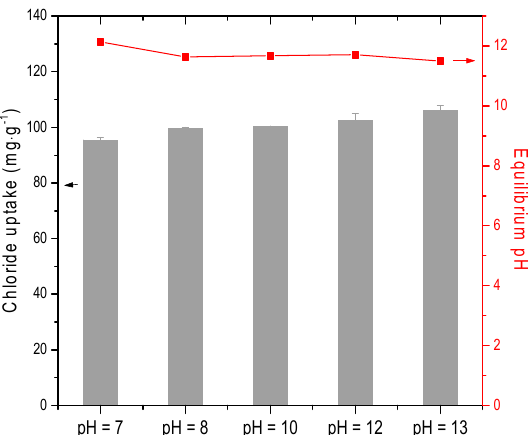
Figure 6. Chloride uptake of CAL-60 in NaCl solution with different pH (temperature = 25 °C; CAL/NaCl solution = 10 g/L; initial chloride ion concentration was set as 80 mmol/L). Figure 7. XRD patterns of CAL-60 and CAL-60 samples after adsorption of Cl − under different